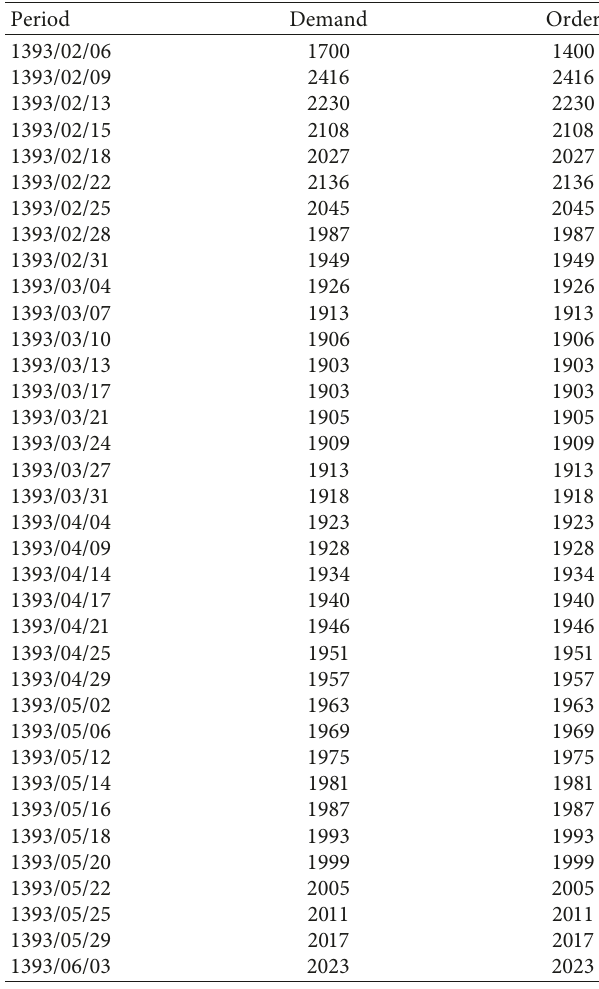
Table 14: Forecasting Zarbal incubator factory by the exponential smoothing